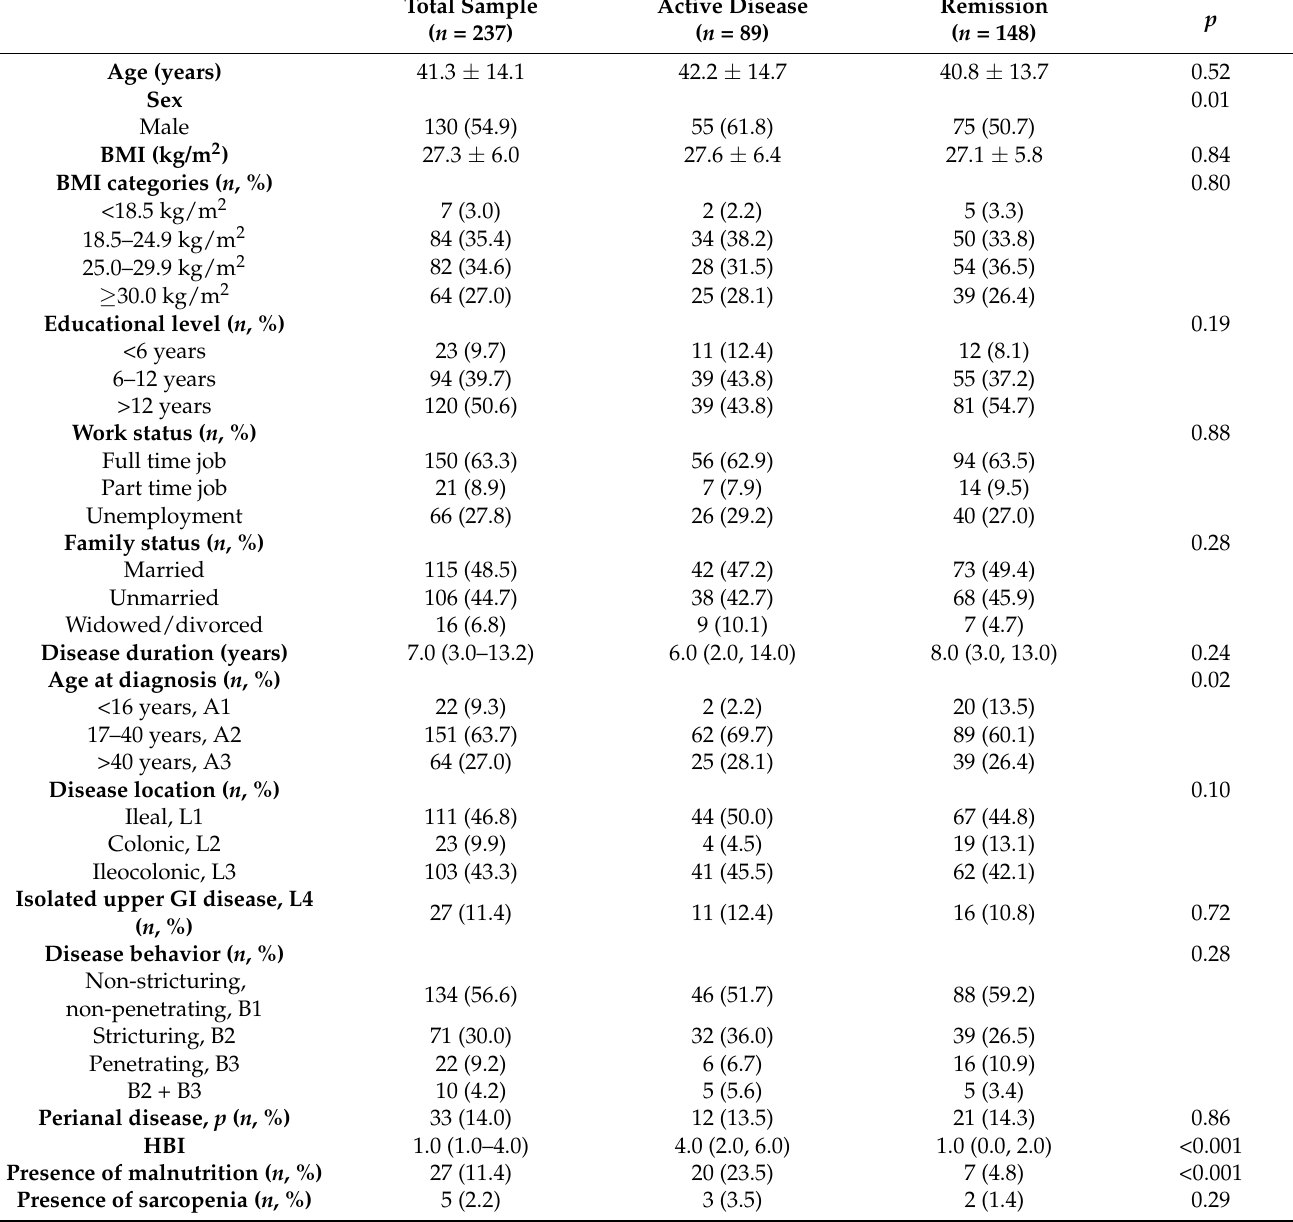
Table 1. Descriptive characteristics of 237 patients with Crohn’s disease and according to disease